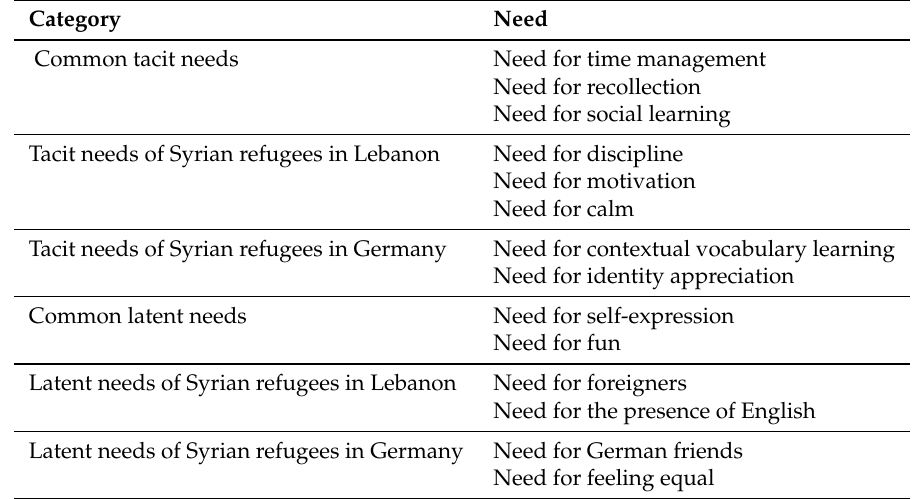
Table 3. Tacit and latent language learning needs for Syrian refugees in Lebanon and